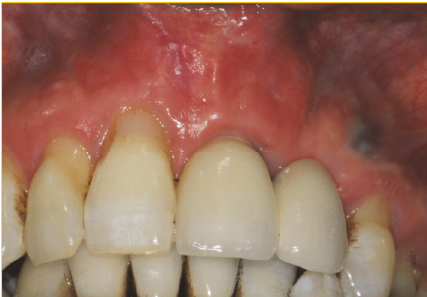
Figure 4: Clinical presentation at initial consultation displaying the erythematous buccal mucosa at implant position 21